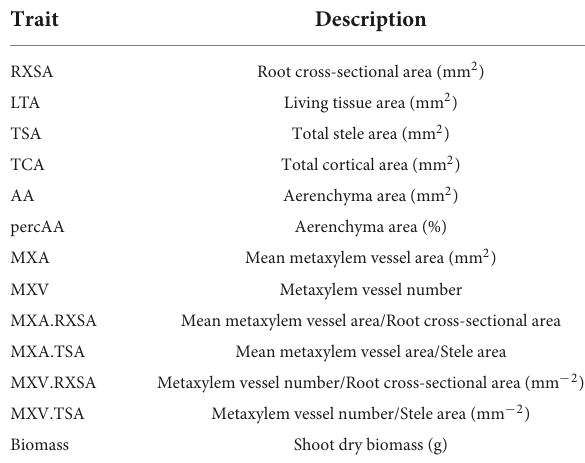
TABLE 1 Description of trait